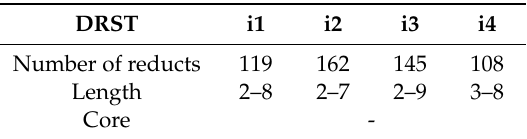
Table 12. Number, size, and cores of designated reducts designated using the DRST method for the selection of sections of watercourses to the scale of 1:50,000.